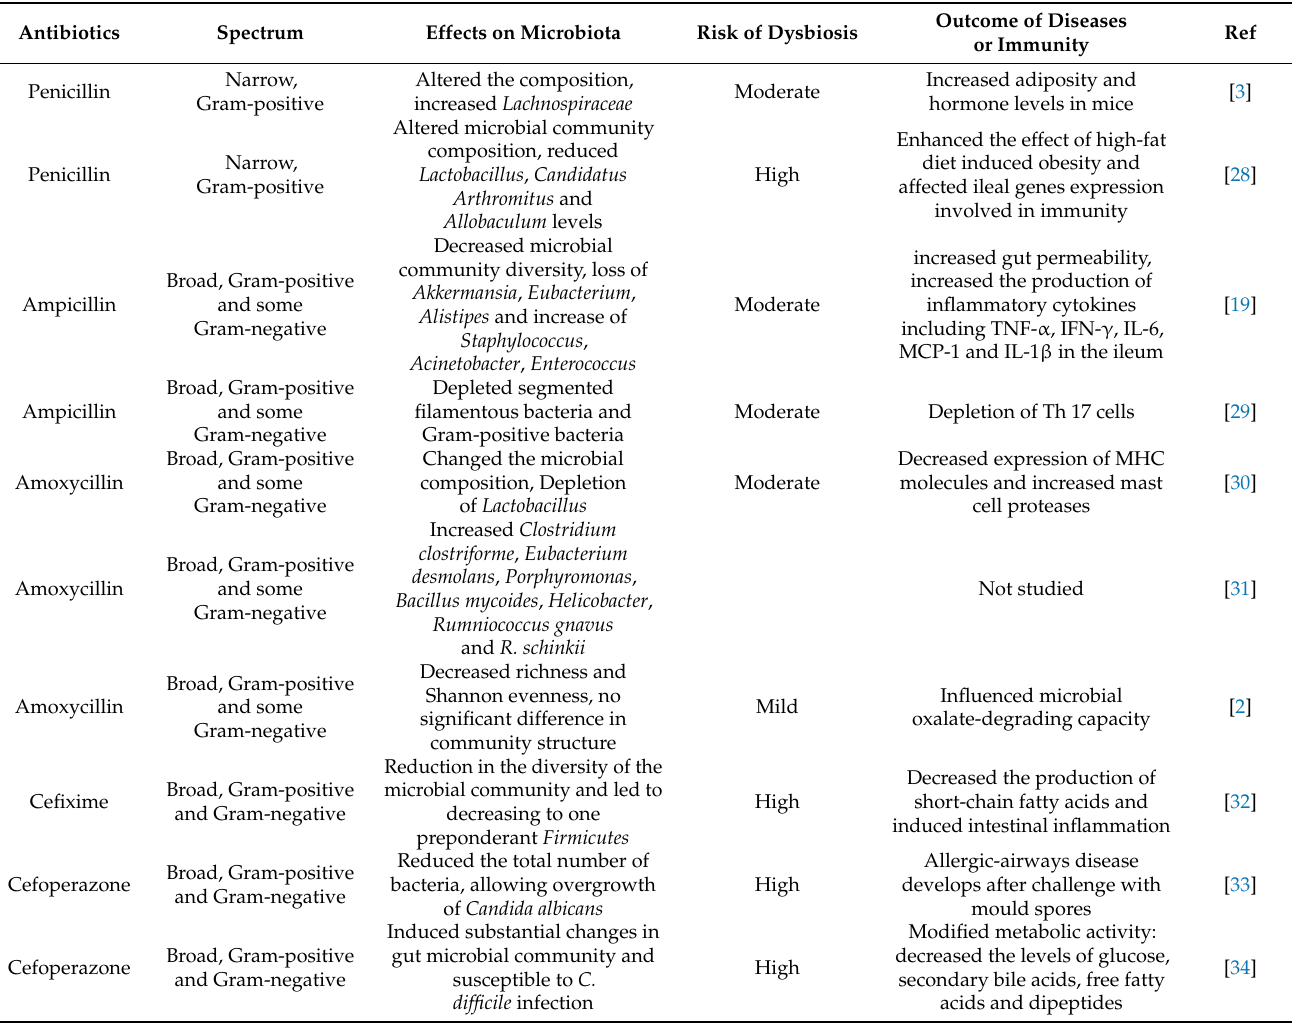
Table 1. Associations between β -actin antibiotics and